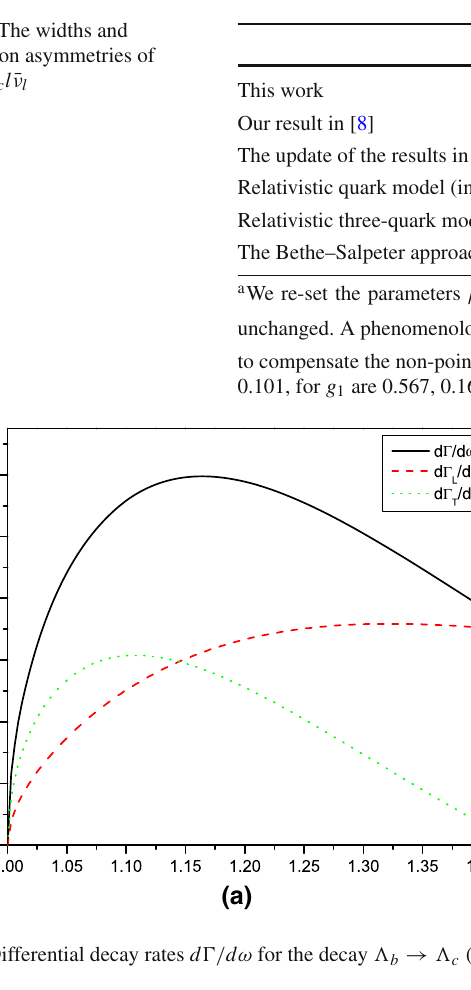
up-down asymmetries of non-leptonic